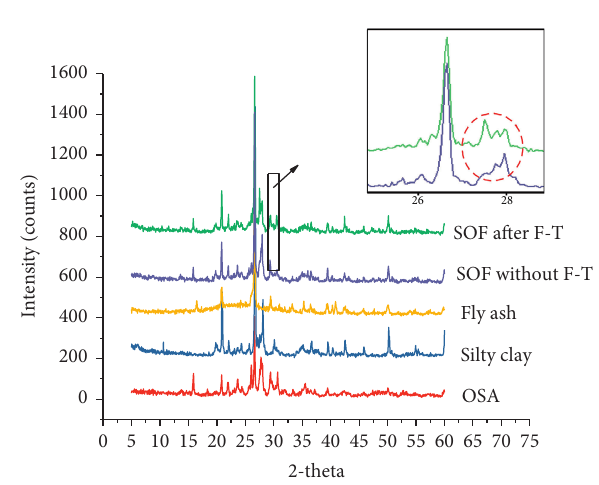
Figure 10: X-ray diffraction reflectograms of test